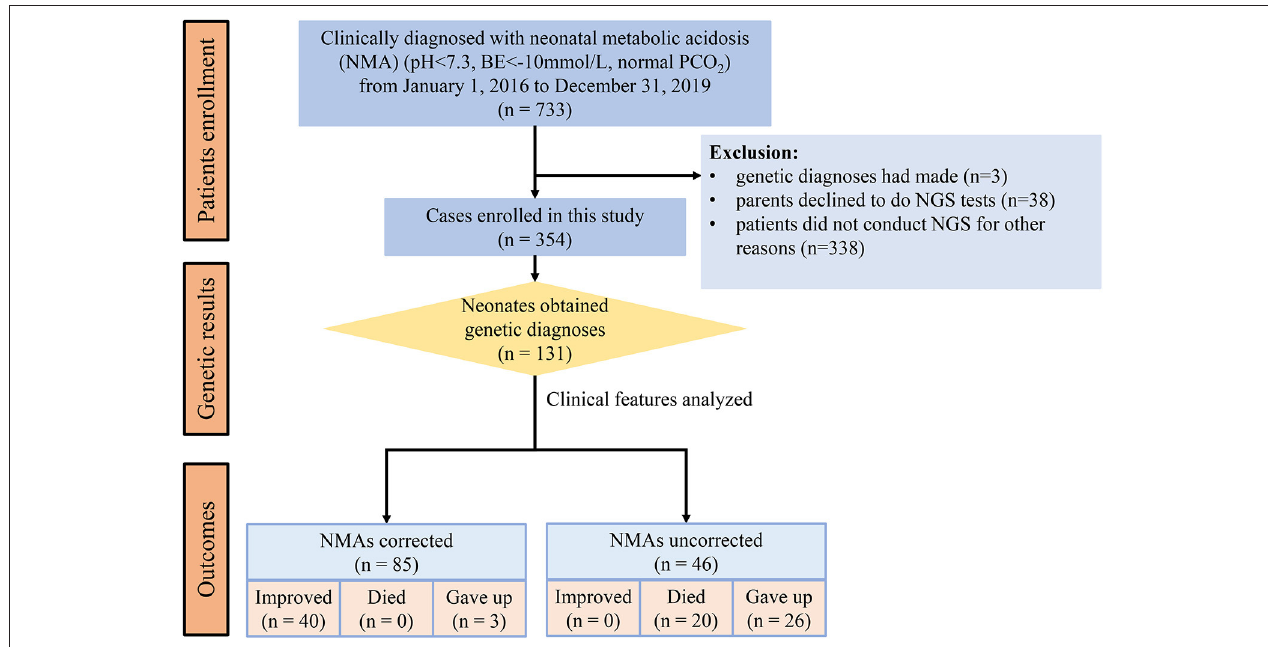
FIGURE 1 | Flowchart of diagnosed patients by NGS.